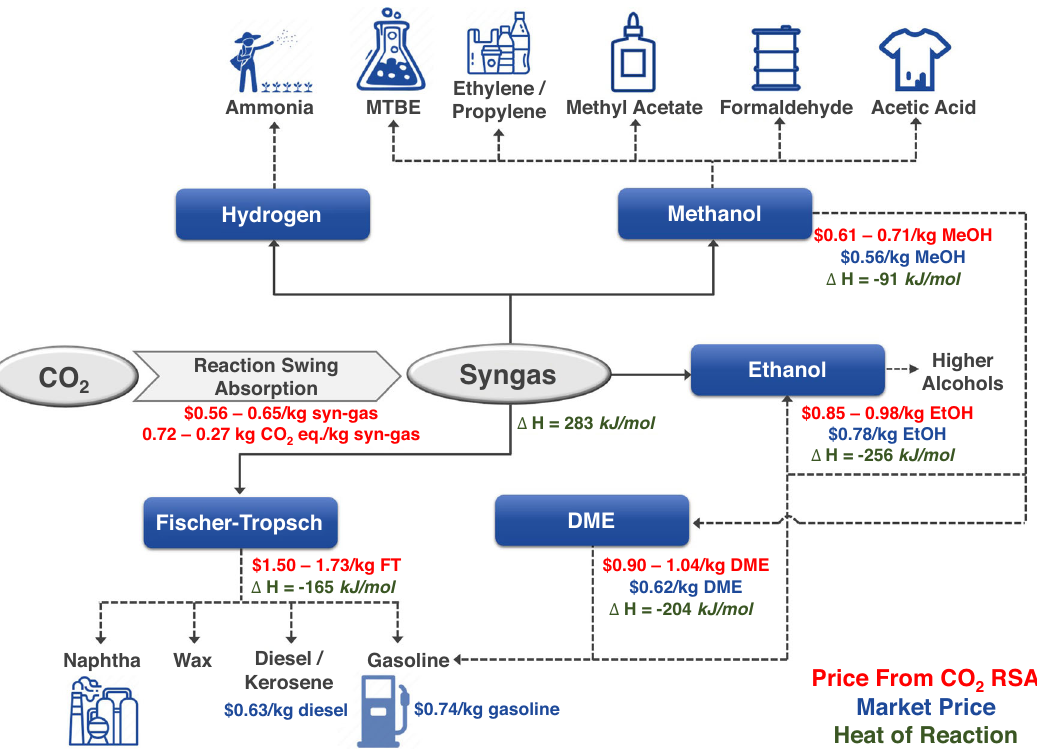
Fig. 5 | Syngas asa versatile intermediate chemicalhaving a competitive price when using the eco-friendlyCO 2 RSA process. Estimatedlevelizedcost of target chemicals produced from consecutive RSA and downstream processes 39 (red),